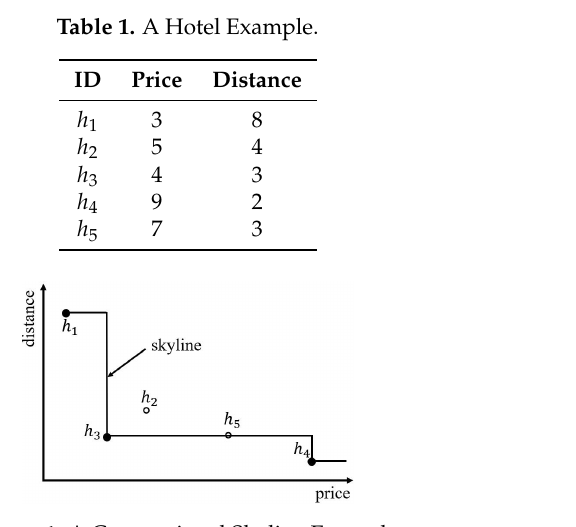
Figure 1. A Conventional Skyline Example.